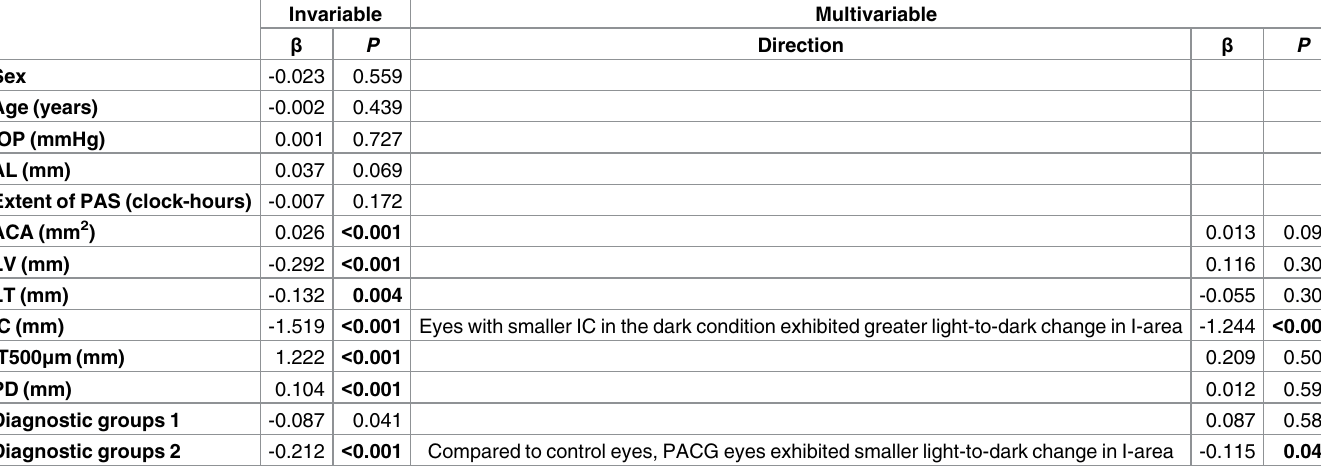
Table 4. Factors in dark condition associated with light-to-dark changes in I-area by univariate and multiple regression between the left eyes of CPACG patients (including 31 PACG eyes and 26 PAC/PACS eyes) and normal control eyes.